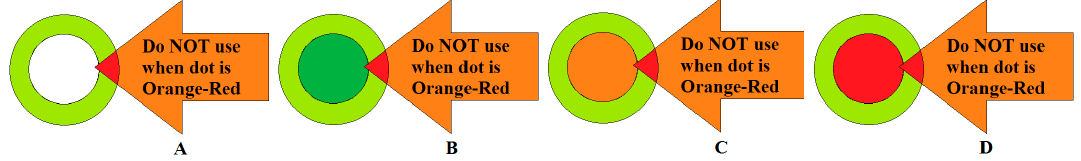
Figure 2. VITSAB TTI label: ( A ) Inactive; ( B ) after removing seal; ( C ) 100% expired; ( D ) 120% expired.